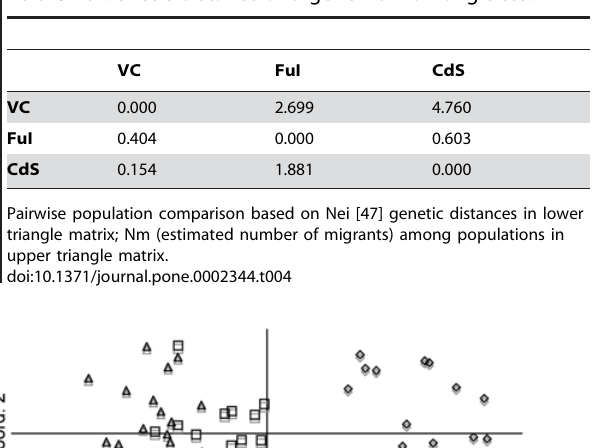
Table 4. Genetic distance and gene flow among sites.